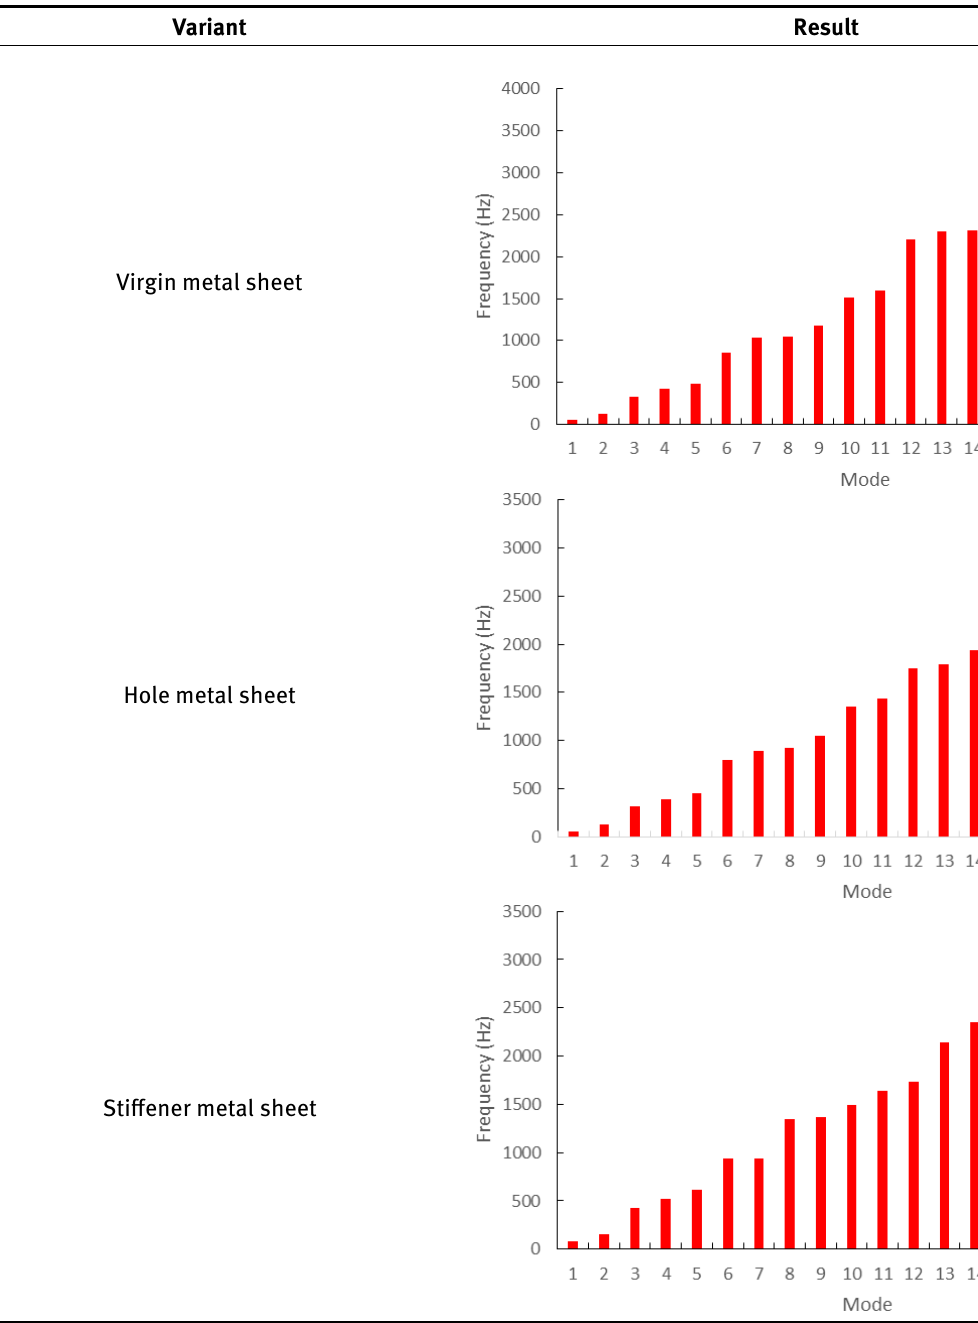
Table 6: Natural frequencies of low-carbon steel material on different models